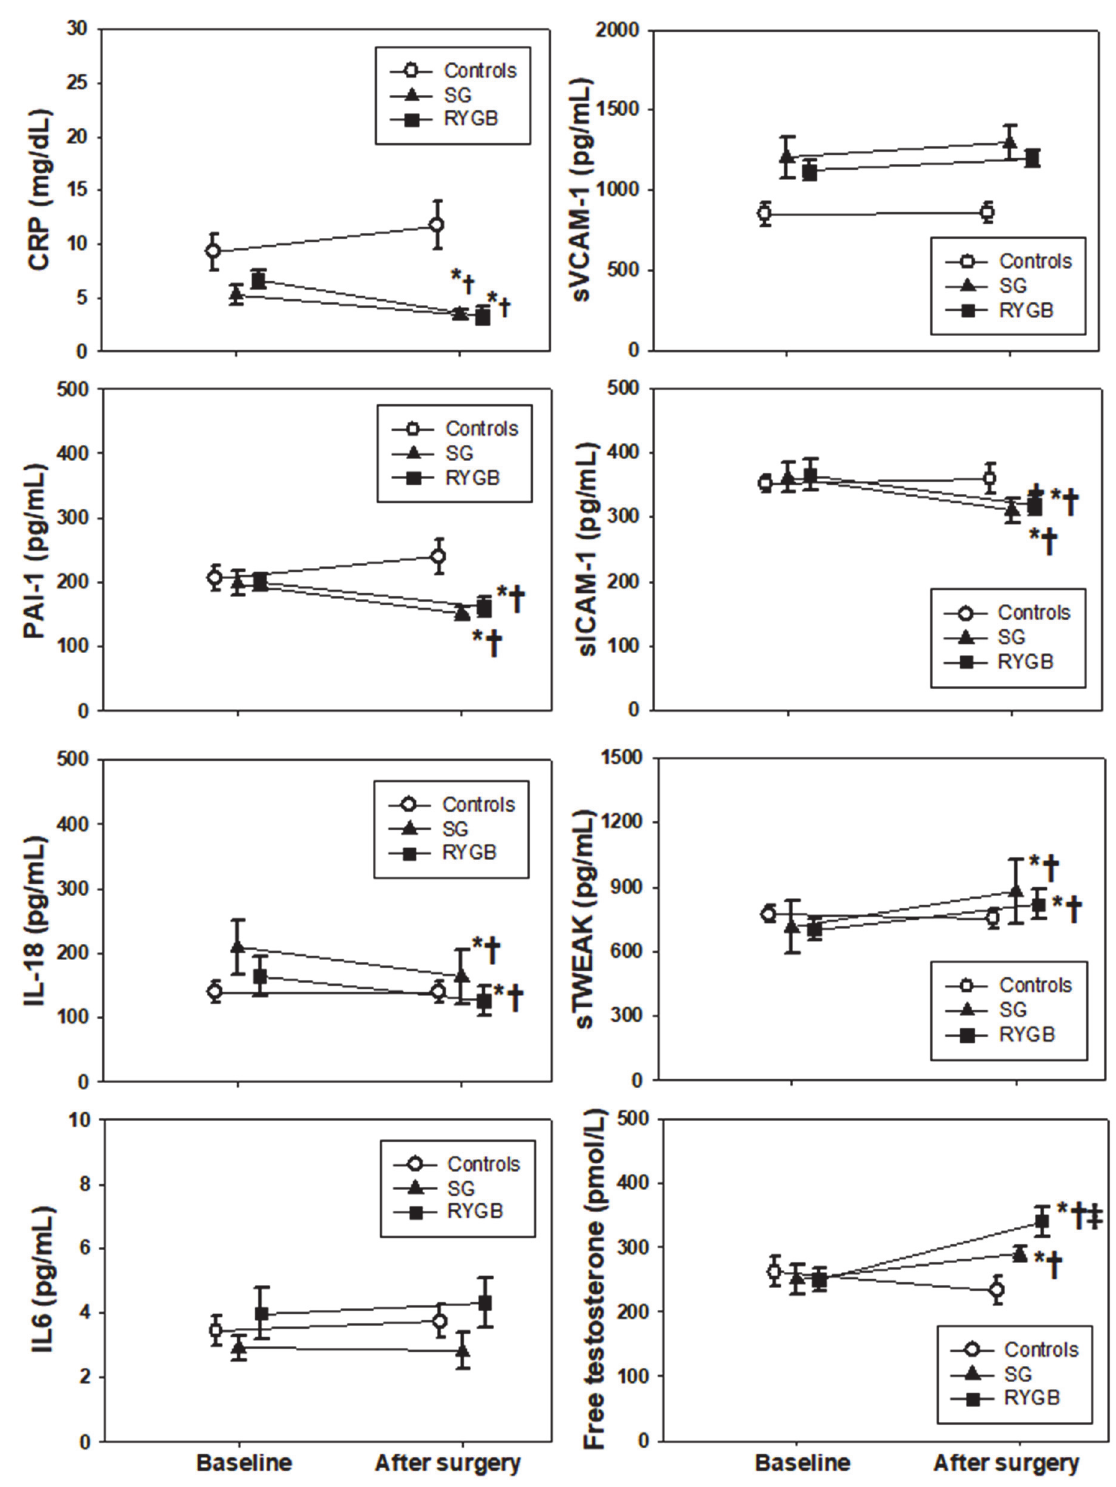
Figure 1. Changes in circulating inflammatory and endothelial biomarkers in the included men after metabolic surgery. Symbols represent means, and error bars represent SEMs. * p < 0.05 from baseline, † p < 0.05 vs. controls, ‡ p < 0.05 vs. SG.